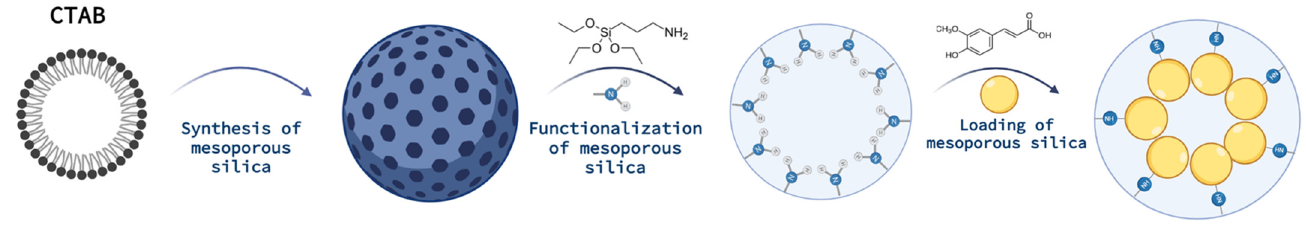
Figure 1. Synthesis of functionalized mesoporous systems loaded with ferulic acid (Created with BioRender.com).